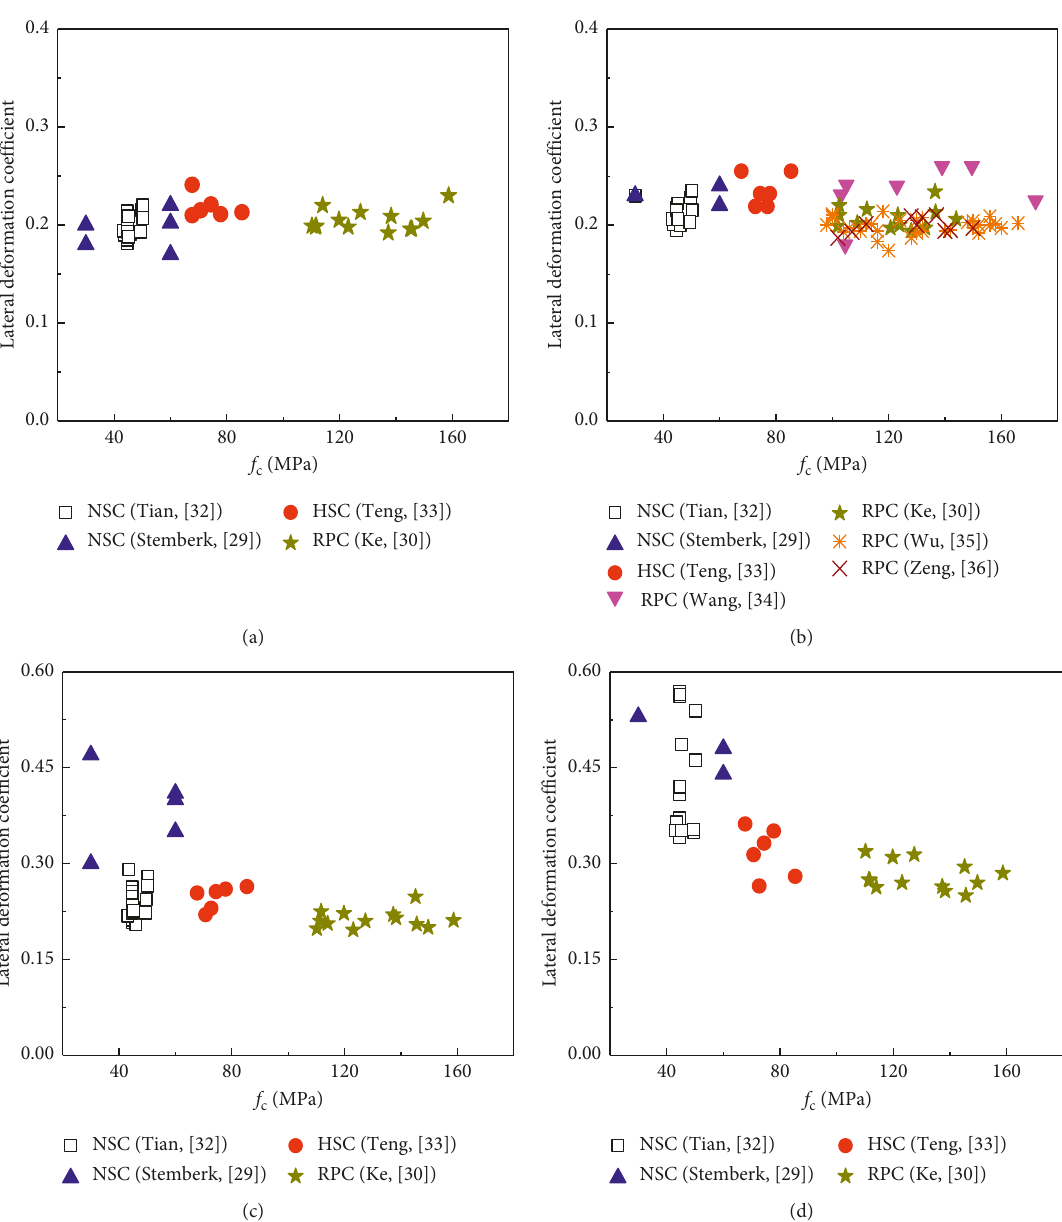
0.2 f c . (b) σ 0.6 f c . (c) σ 0.8 f c . (cid:31) (cid:31) (cid:31)